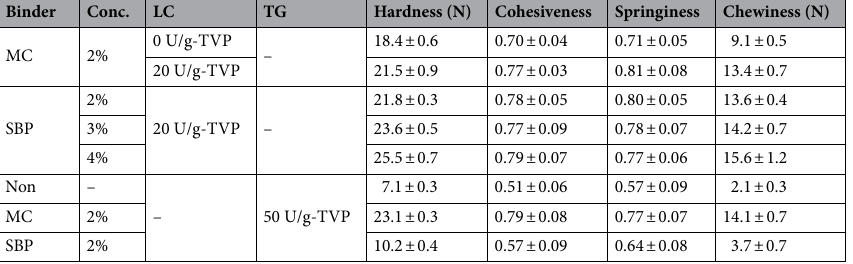
Table 1. Texture profile analysis of meat analogs. Meat analogs were treated with 20 U/g-TVP LC or 50 U/g- TVP TG in the presence of MC or sugar beet pectin. Data are presented as mean ± standard deviation of five experiments.